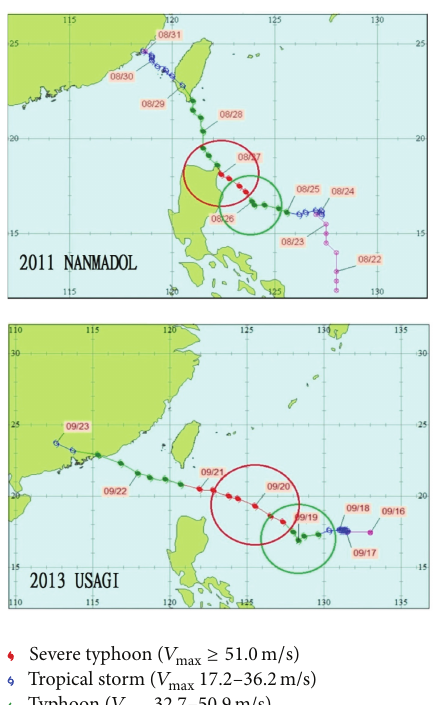
Figure 1: Charts for tracking the movement of typhoons Nanmadol and Usagi (data from Taiwan